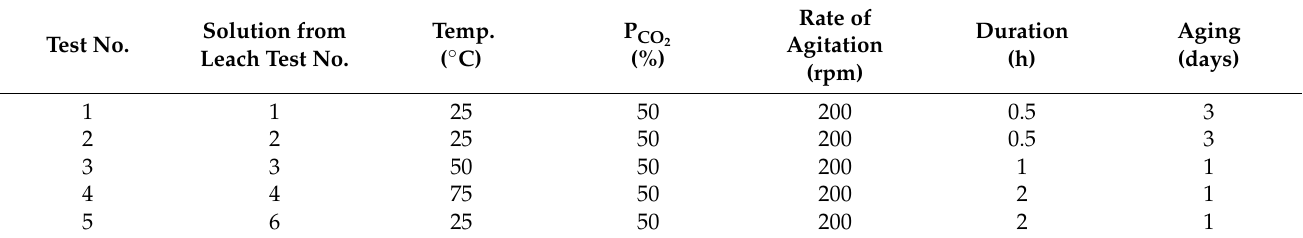
Table 5. Schedule of precipitation